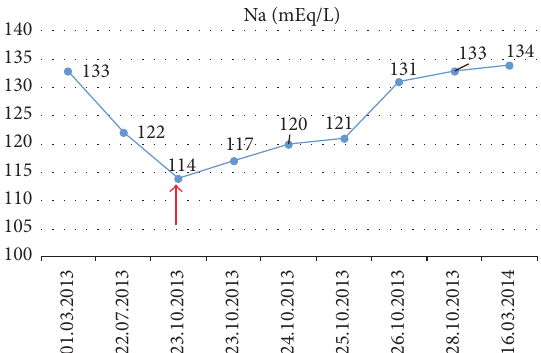
Figure 1: Evolution of serum Na levels since the diagnosis and treatment (03/01/2013) of glossopharyngeal squamous cell carcinoma until six months after discharge from Internal Medicine Department (03/16/2014). The moment of hospital admission is marked with the red arrow